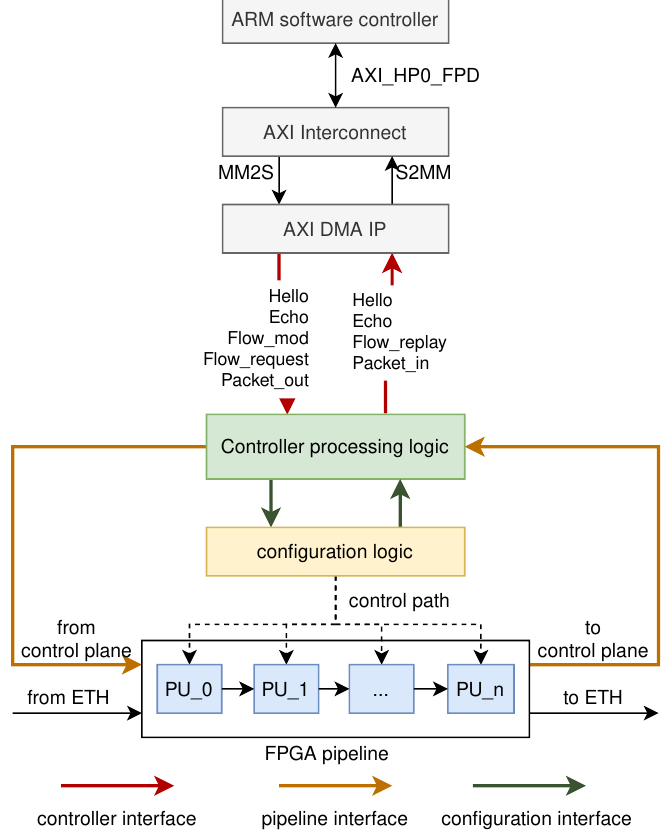
Figure 7. The communication between the control plane and the data plane. Table 2. Part of a message